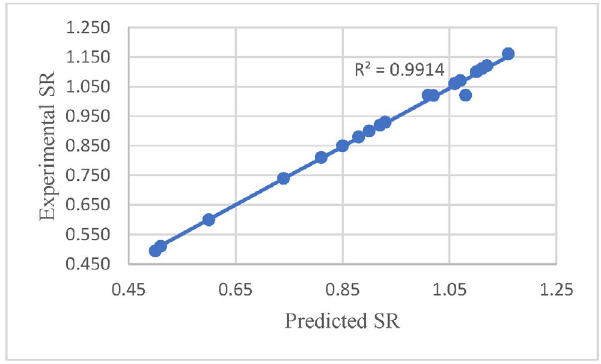
Figure 9. ANFIS regression line for training.